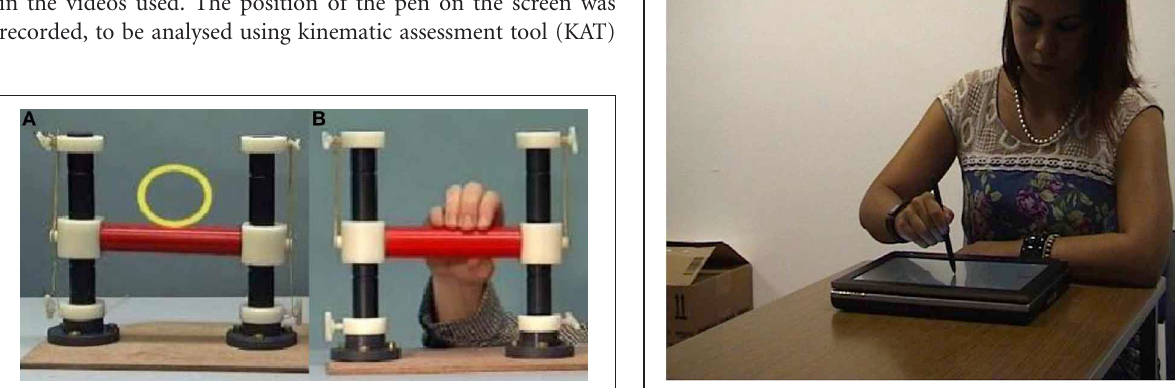
FIGURE 2 | Still frame of video-clip showing model drawing